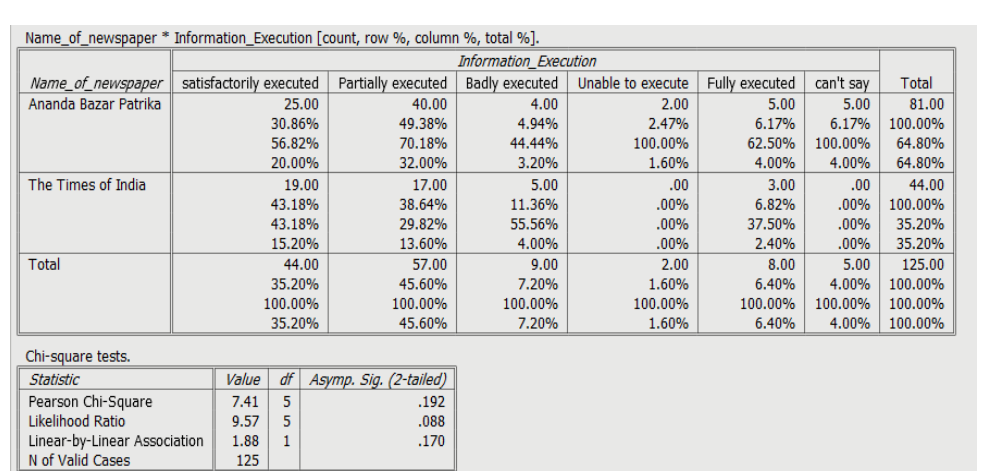
Figure 11: Cross tabulation and Chi-square between Newspaper v/s Information Execution (Source: Authors‟